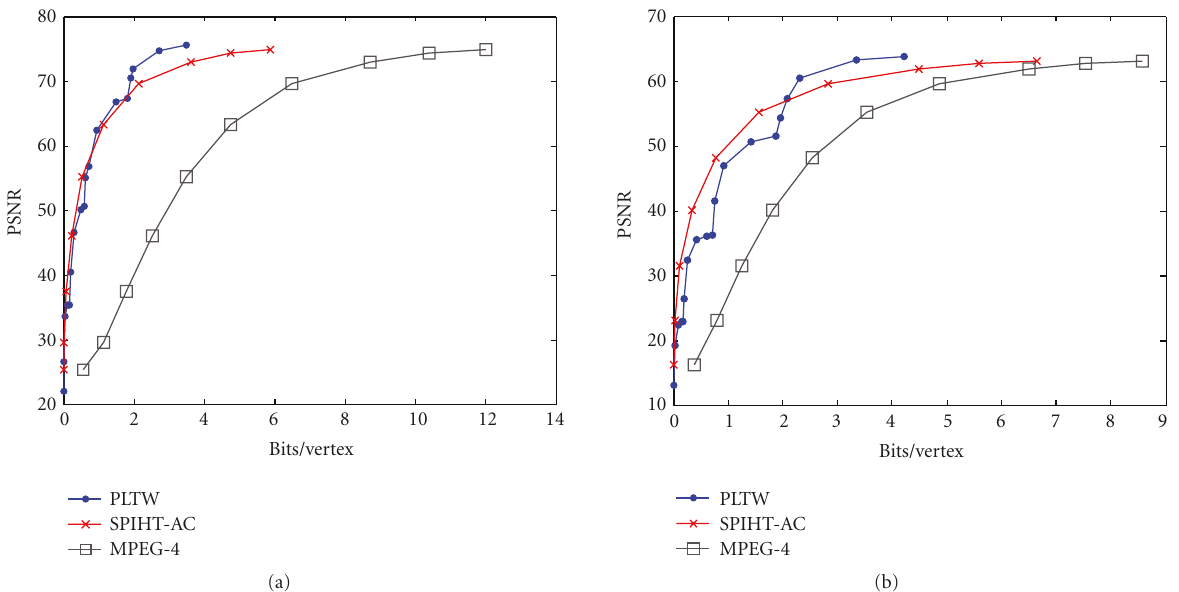
Figure 3: PLTW versus SPIHT and MPEG-4’s “WaveSurf” for the Max Planck and bunny